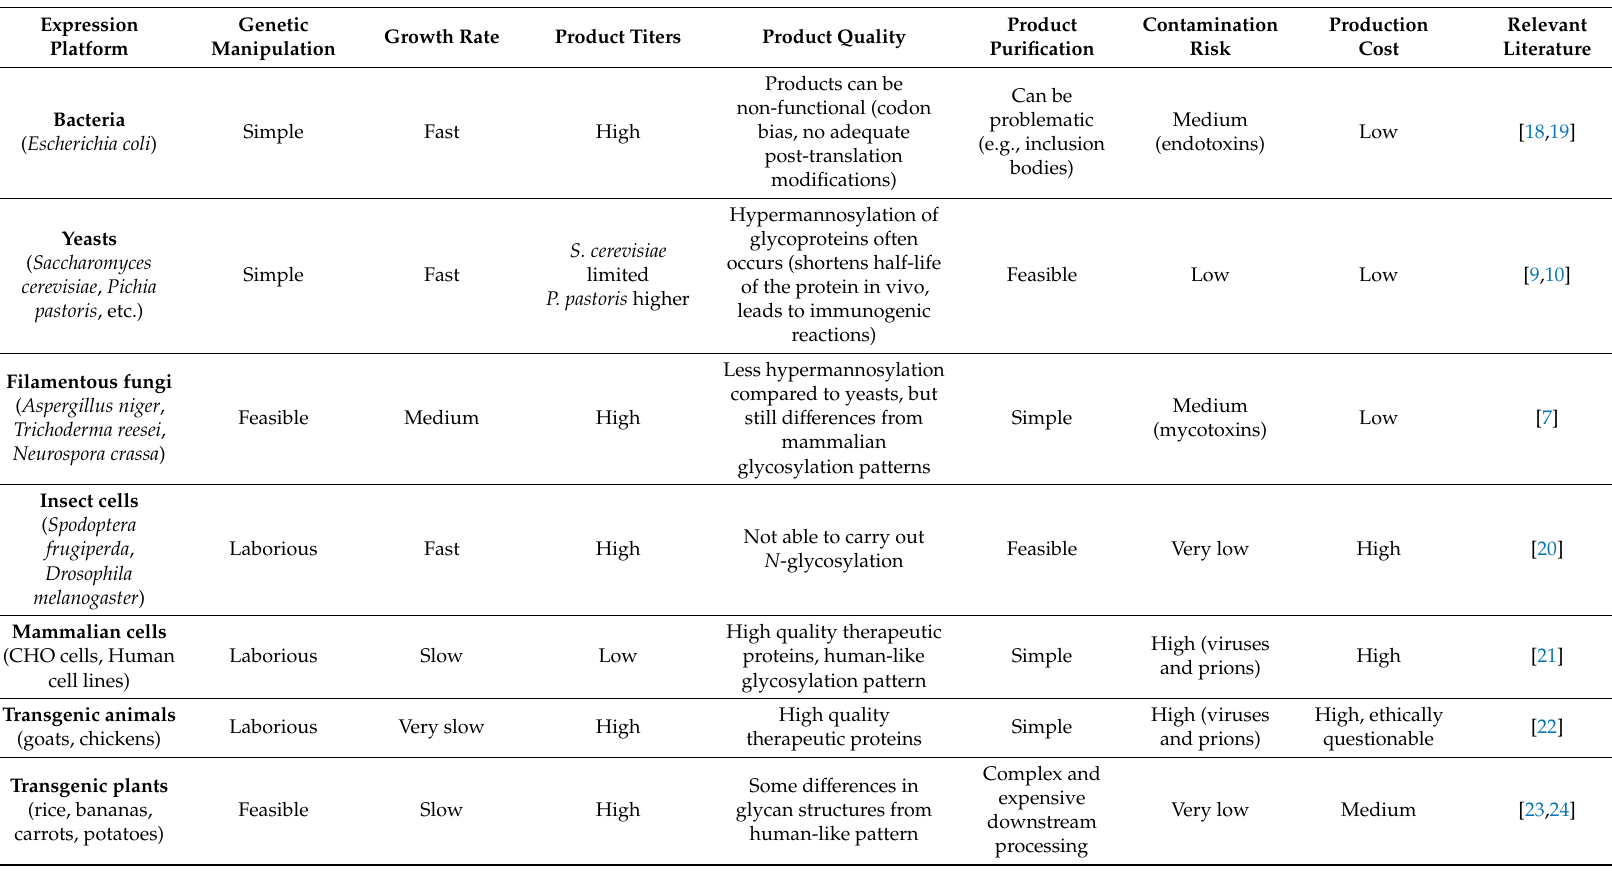
Table 1. Comparison of the most commonly used heterologous expression systems in the field of recombinant protein production. Expression